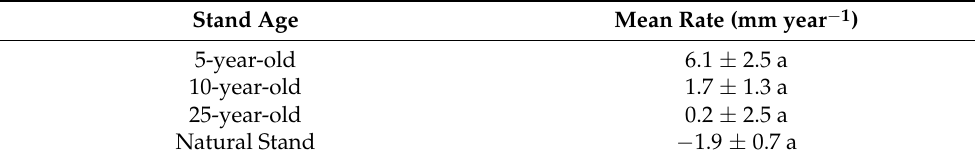
Table 3. Summary of mean rates of sediment elevation change (mean ± SE) of the study sites. Stand